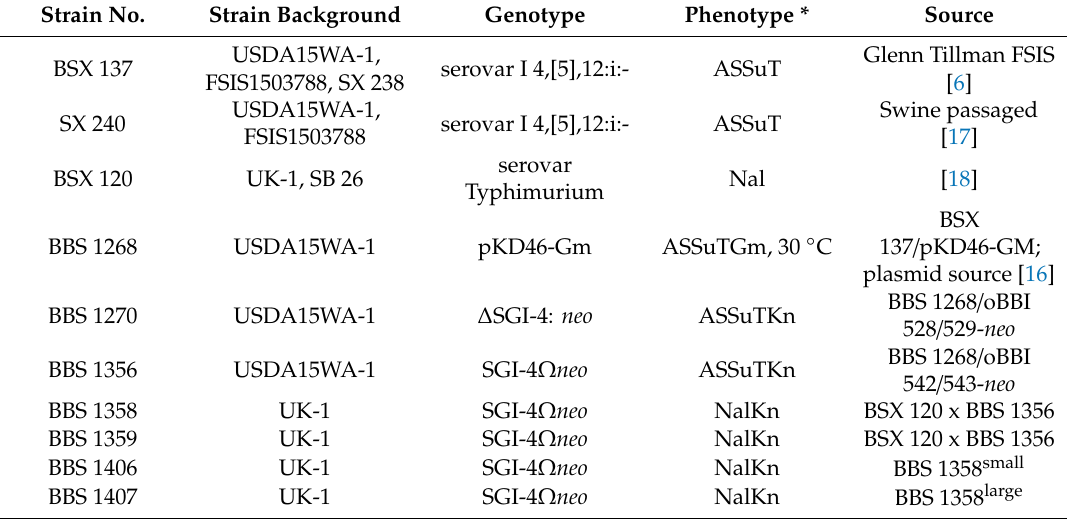
Table 1. Salmonella enterica